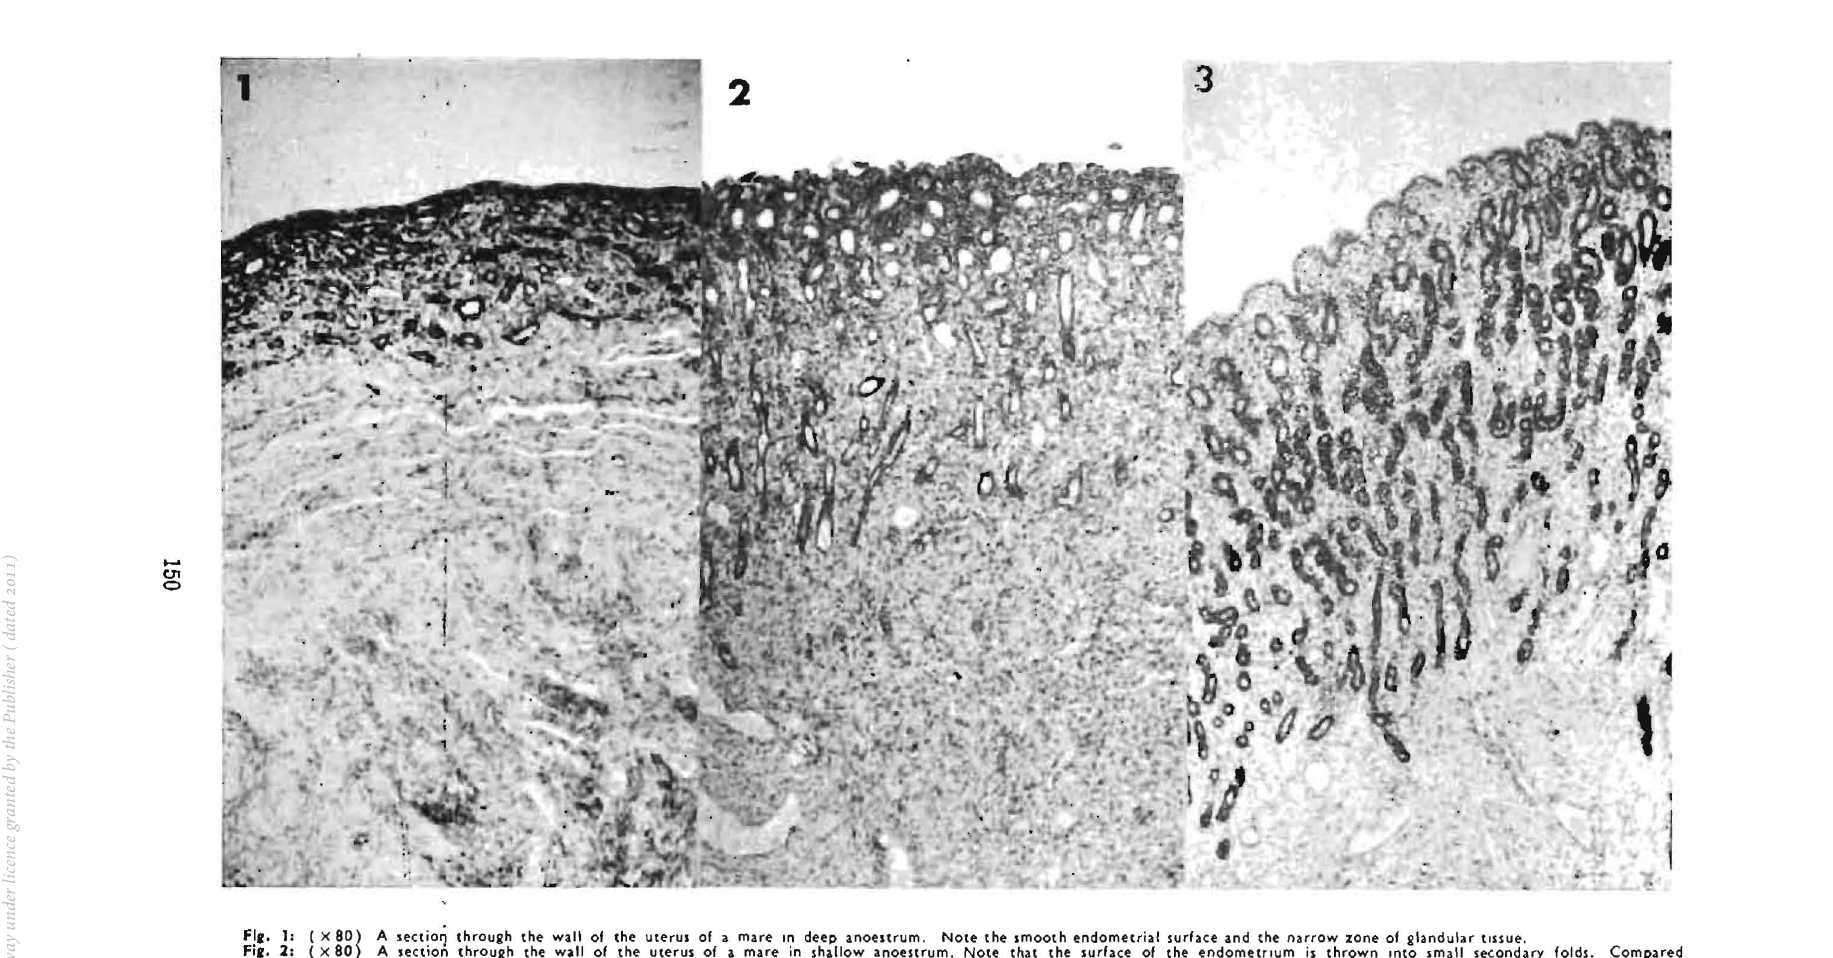
FI,. 1: ()( BOl A !ItClio,} through the wall of the uterus of it mare In deep anotltrum. Note the smooth endometrial surf3ce and the narrow zone of glanduhr tissue. Fi,. 2: ()( 80 A section through the wall of the uterus of a mare In shallow anoestrum. Note that the surface of the endometrium I, thrown Into small sec.ondary folds. Compared with Hg. 1. (he alandulH ,zone is about twice as wide, there are more glands present and the diameter 01 (he glands is greater. FI,. l: ( x 80) A section through the w ... 11 of the uterus of a mare durinll an abnormally long oestrous period. Compared with Fig. 2. the secondary folds on the endometrial surface Ire larger, the glandulAr zone is about twice as wide. there are more Rlands per unit area and they are more coiled. FI •• 4t (x512) A hi2he'r magnification of Fig. I. The epithelial cells 3re cuboid31 with a small amount of cytoplasm and small nuclei, The epithelial cells of the glands are small. con densed ... nd suin darkly. ! Fl •• 5: (x 512) A higher magnification of Fig, 2. Compared with FiR. 4. the surface epl(helial cells are much higher. being low columnH. The nuclei He IHge. oval and lie vertlully to the basement membran~. The diameter of the p,lands is greater and the epithelial cells are about as large as the surface epithel,al cells 3lthouRh their nuclei are smaller, FIR. , : ( x 512) A hiflher magnificuion of Fig. 3. Compared wi(h FiR. S. the surface epithelial cell layer is higher. now being 1311 columnar with a IHge amount of cytoplasm. The 1H2e oval vesicular nuclei' are more densely packed and lie vertically to the basement membrane. The glanduhr epitheli31 cells are smaller than the surface cells. but somewhat larger (h.n (h. gl.ndular coli, of Fi~.